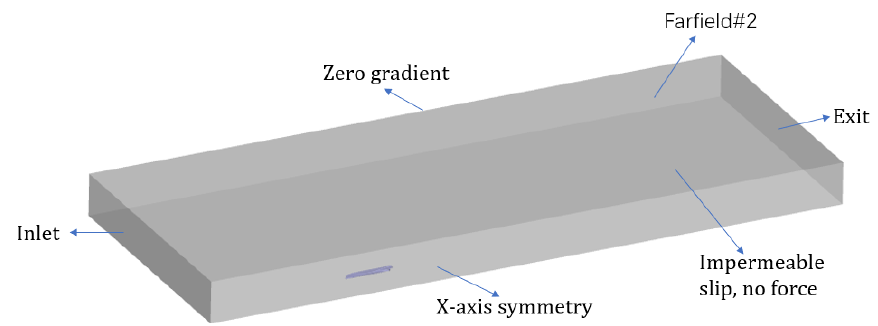
Figure 5. The computational domain for the full-scale calculations.